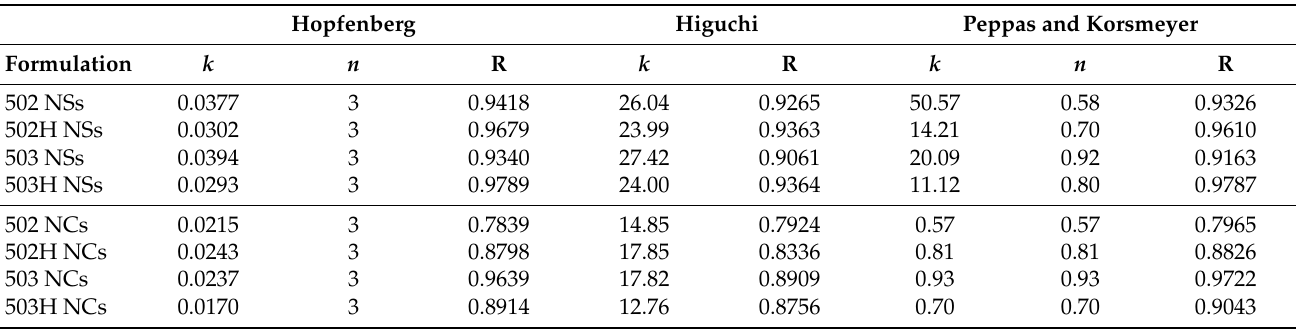
Table 2. Release data of Lf-loaded PLGA NSs and NCs into the Hopfenberg ( M t / M ∞ = 1 − [ kt ] n